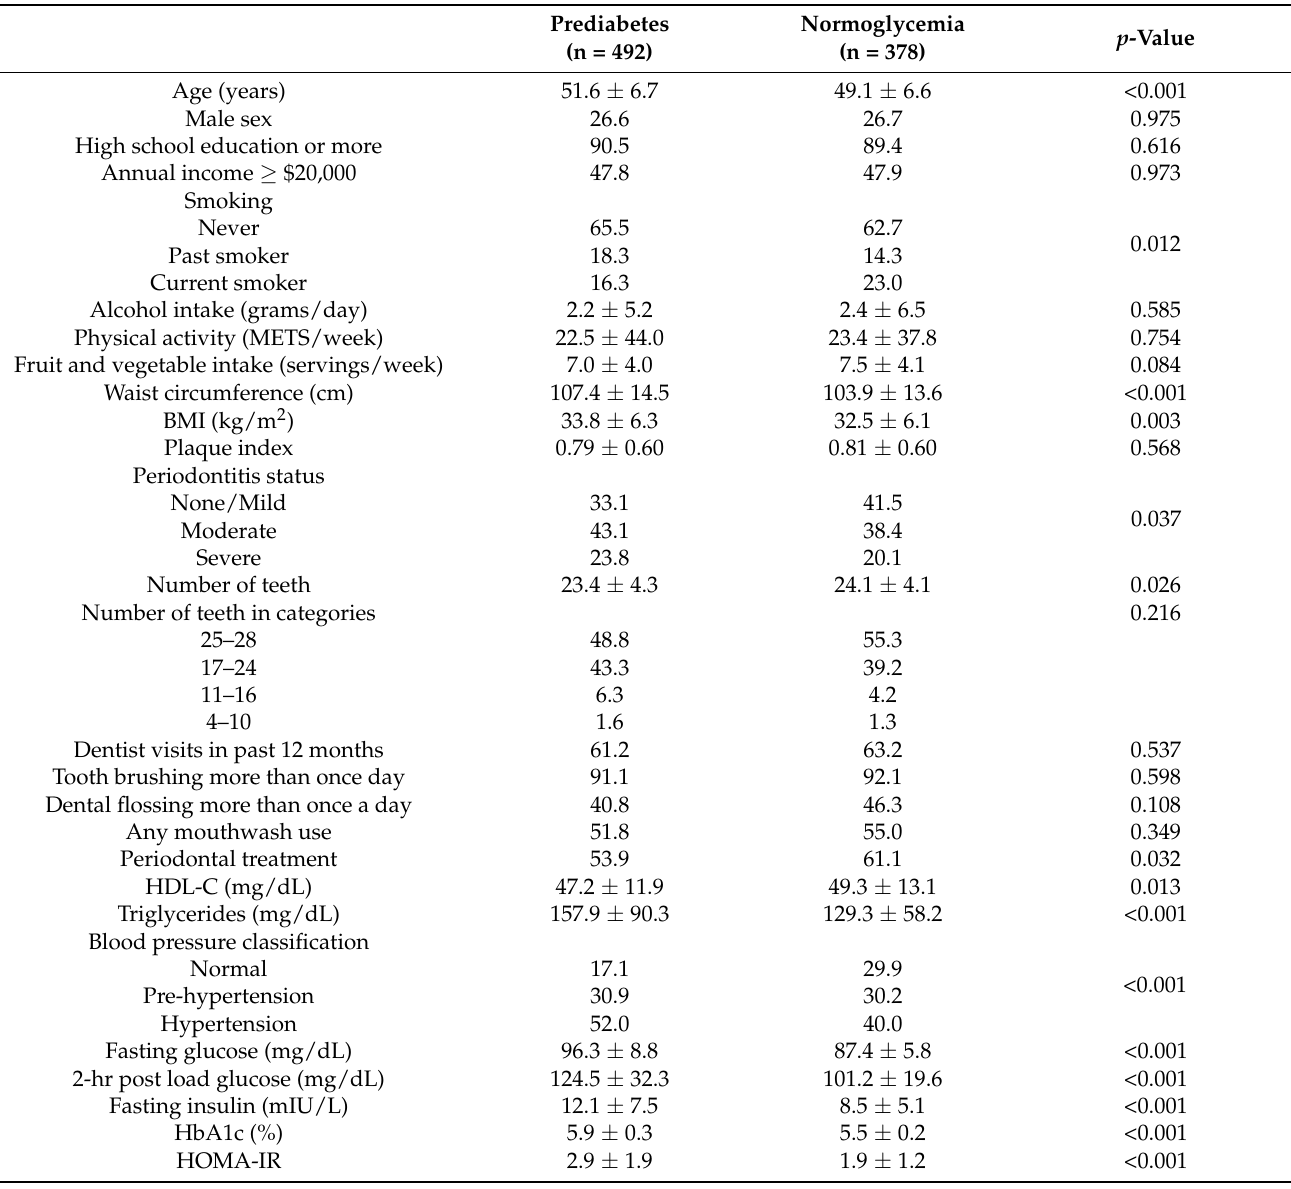
Table 1. Baseline characteristics of SOALS participants across glycemic status (n = 870)